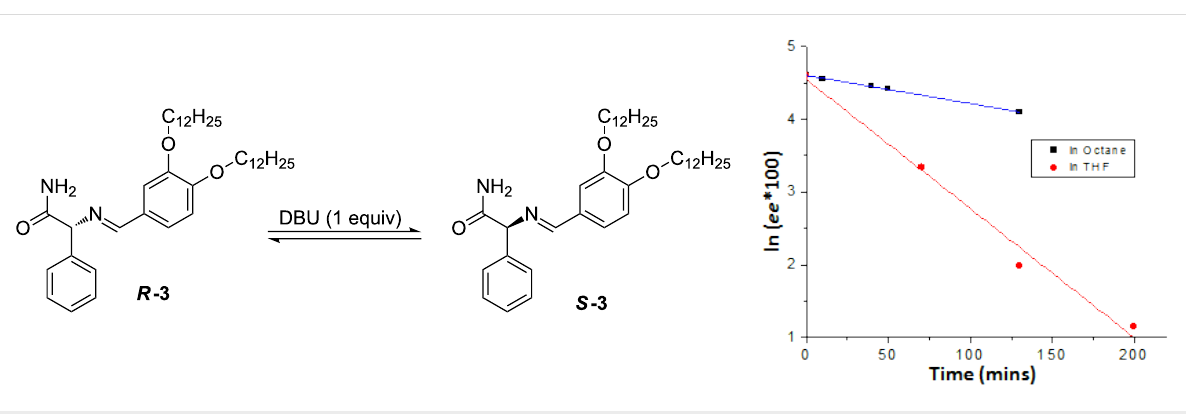
177 min. Under the same conditions, the racemization rate